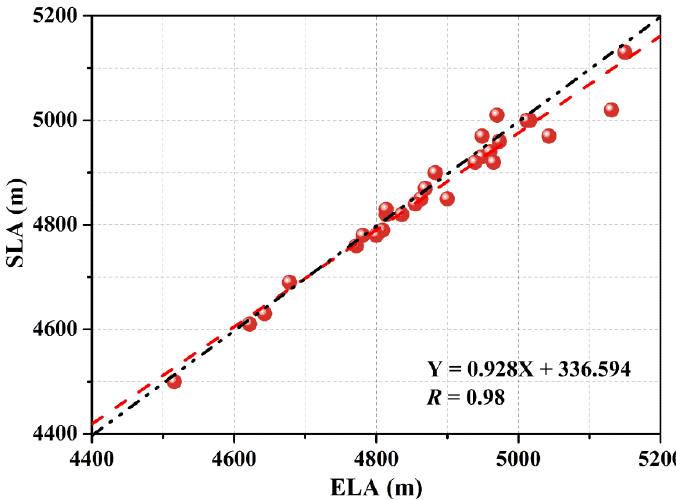
Figure 6. Relationship between the remote-sensing-derived SLA and measured ELA of Qiyi Glacier in the Qilian Mountains. The black dot–dash line represents the 1:1 line.